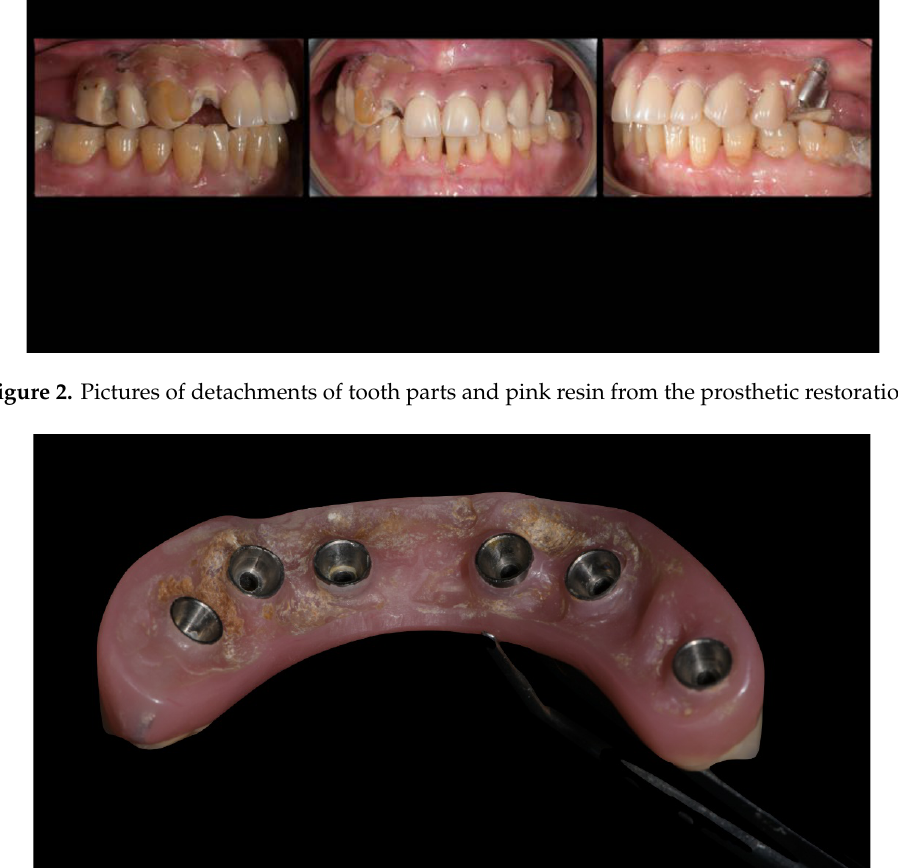
Figure 3. The internal part of the prosthetic restoration, the one in contact with the mucosa, shows the incorrect shape of the pink flange, which leads to the accumulation of plaque and food.